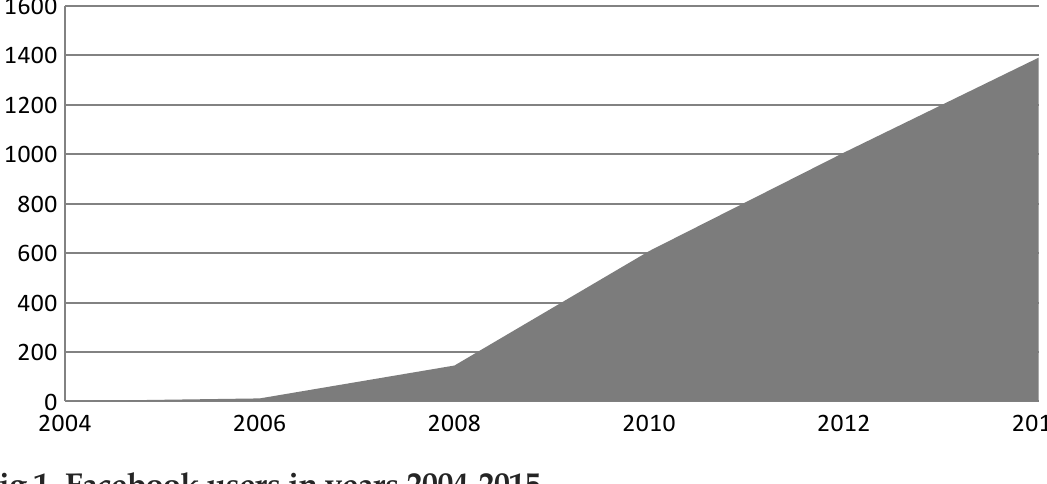
Fig.1. Facebook users in years 2004-2015 Source: Noyes D.(2015), also: Richter